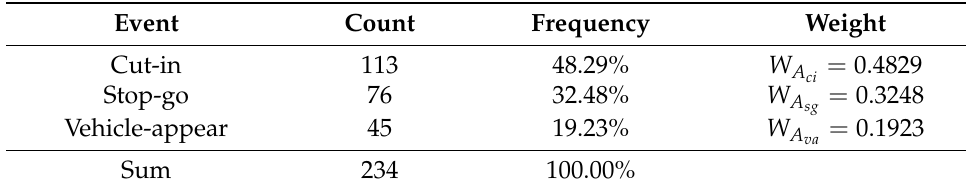
Figure 5. Frequency of acceleration with different speed. Table 2. Event